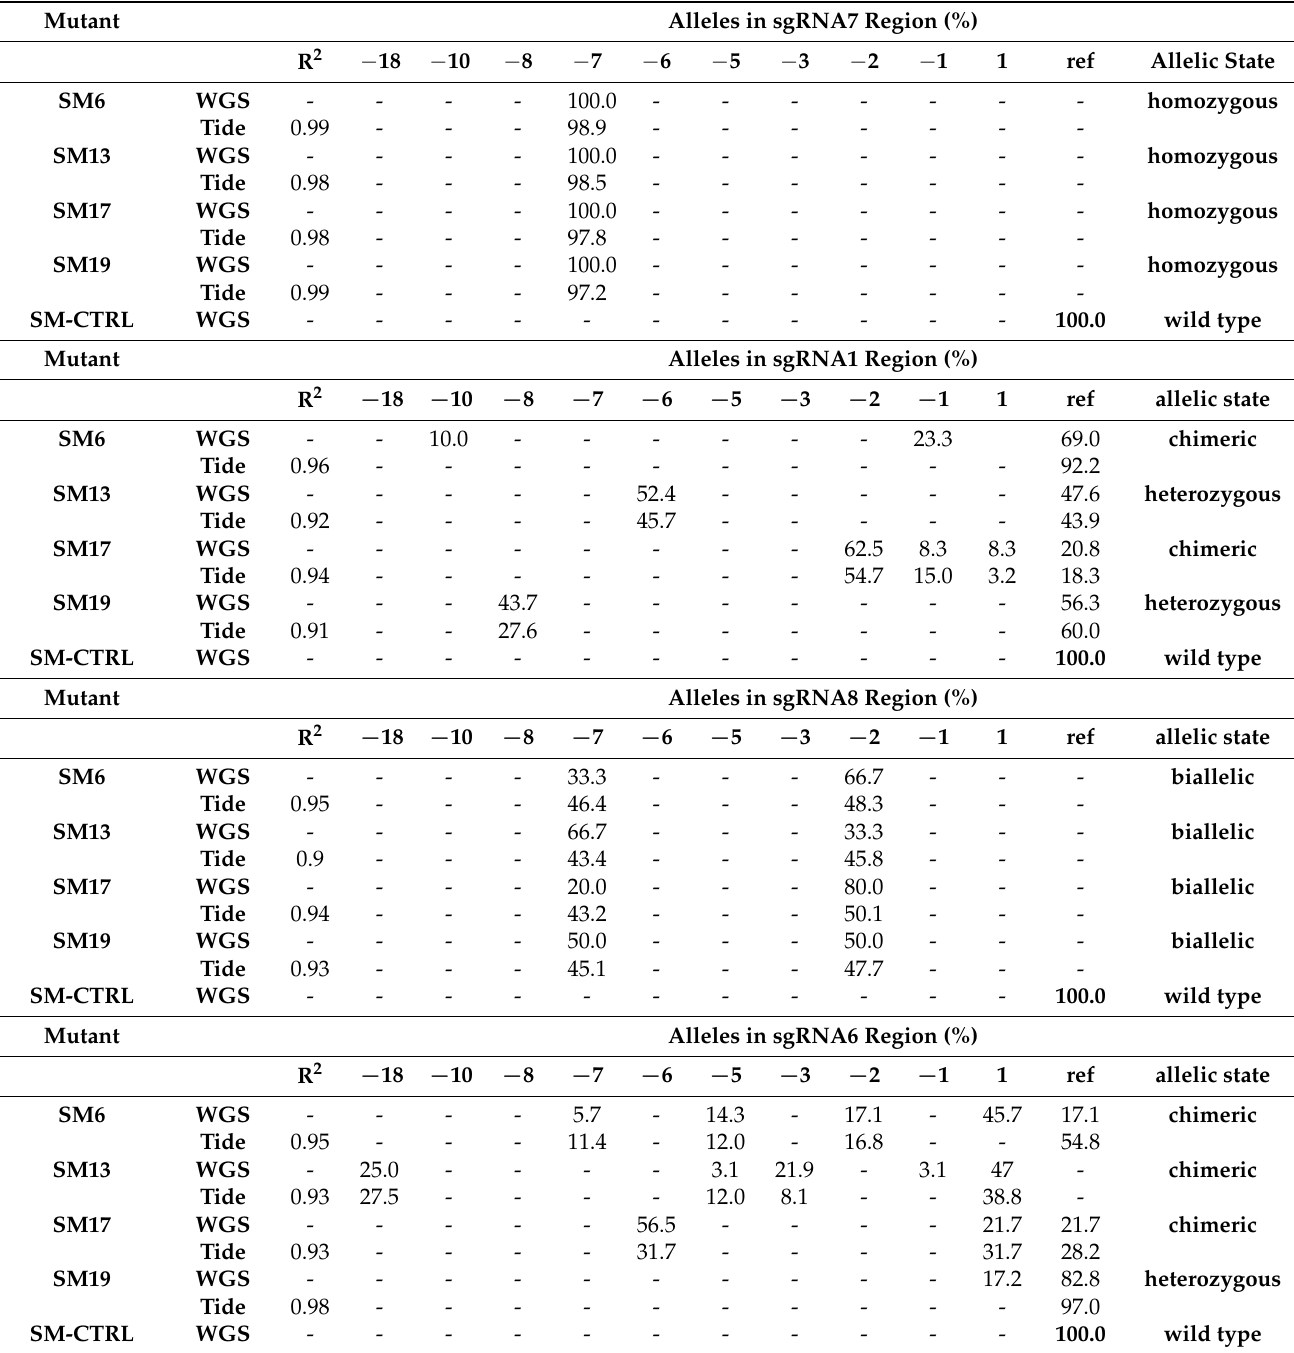
Table 2. Editing effects and observed allelic forms (%) in each of the four sgRNA regions, in four selected genotypes and the San Marzano control. Data were retrieved through: (i) Illumina sequencing analysis, analyzed with CRISPResso2; and (ii) TIDE analysis of Sanger sequences; the overall efficiency of each TIDE analysis is calculated as R 2